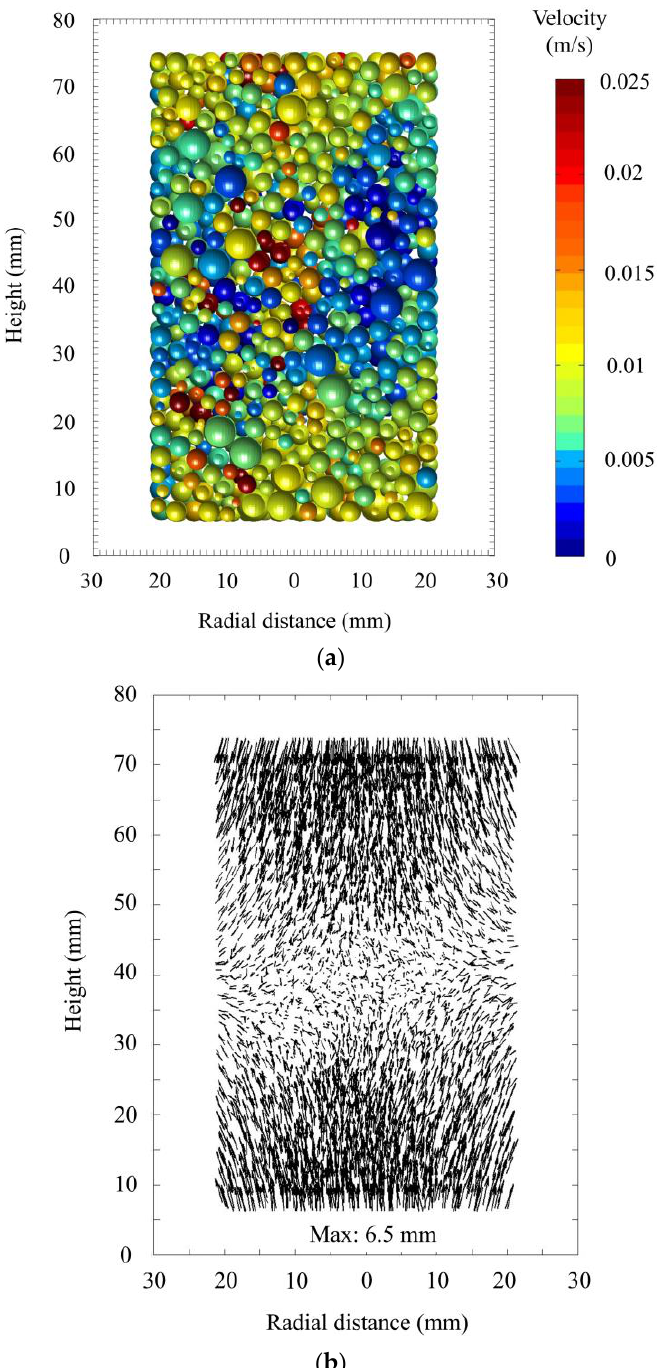
Figure 6. Deformation and mechanical profiles of sample at axial strain of 6.2% (3920 particles). ( a ) transient velocity ( b ) accumulative displacement.